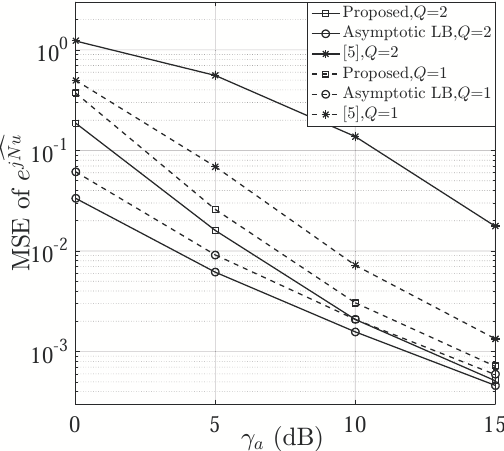
Figure 3. MSE of e j (cid:99) Nu versus γ a ( M = K = 8 and T =